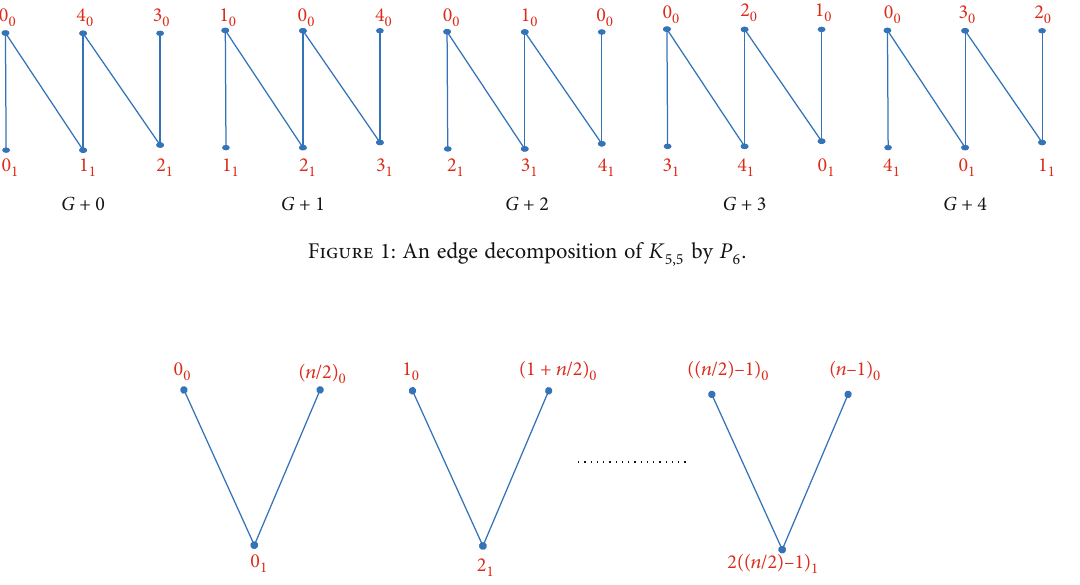
Figure 2: An orthogonal labeling for ð n /2 Þ K